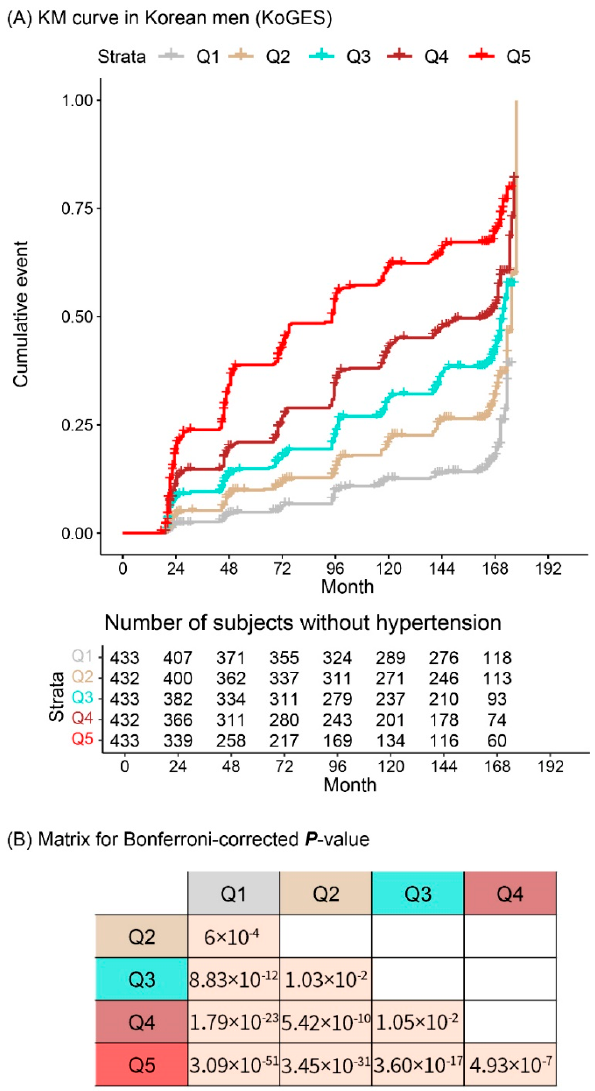
Figure 3. ( A ) Difference in cumulative incidences of new-onset hypertension between the five groups divided according to the expected probabilities in men in the KoGES study. ( B ) p -value matrix. Abbreviations: KM, Kaplan–Meier; KoGES, Korean Genome and Epidemiology Study; Q,